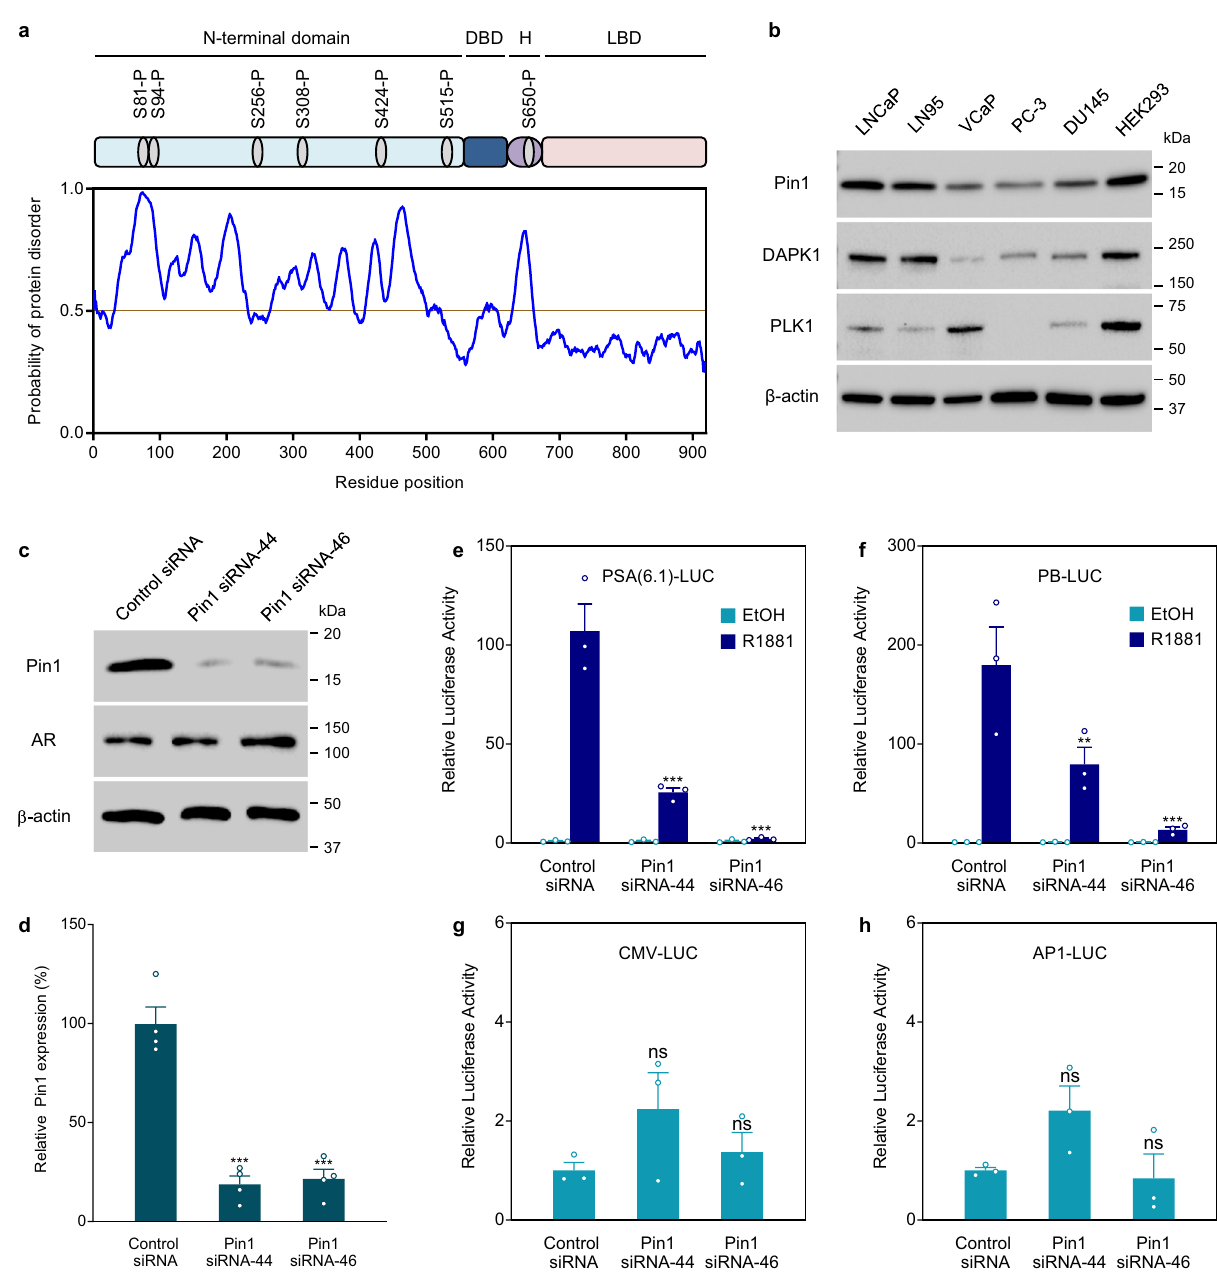
Fig. 1 Pin1 is essential for the ligand-dependent transcriptional activity of AR. a Schematic depicting the position of putative Pin1 motifs on AR, which are based on experimentally veri fi ed phosphorylation sites from the Phospho.ELM database. Below, the RONN plot shows regions of predicted protein disorder where scores are above the 0.5 threshold. The numbering of residues is based on the 919 amino acid reference sequence for human AR, NCBI Accession No. AAA51729.1. DBD DNA-binding domain, H hinge region, LBD ligand-binding domain. b Western blot analysis of Pin1, DAPK1, and PLK1 expression in human prostate cancer cell lines and HEK293 cells (positive control) maintained in media supplemented with serum. c Pin1 protein levels in LNCaP cells after incubating with siRNA for 48 h. A non-targeting siRNA was used as a control. d Graph summarizing the knockdown ef fi ciencies of the Pin1 siRNAs. e , f The activities of AR-driven reporters PSA(6.1 kb) and Probasin (PB) luciferase in LNCaP cells incubated with siRNA and androgen (R1881, 1 nM) for 48 h. g , h Activities of CMV- and AP-1-luciferase reporters which are not regulated by AR. Results shown are the means± s.e.m. from three independent experiments. Statistical signi fi cance was determined by two-way ANOVA using Dunnett ’ s multiple comparisons test. ** P < 0.01, *** P < 0.001; ns, not signi fi for PSA and PB, respectively, which is consistent with the conversion of 13cisRA to ATRA by cellular retinoid isomerases 27 .